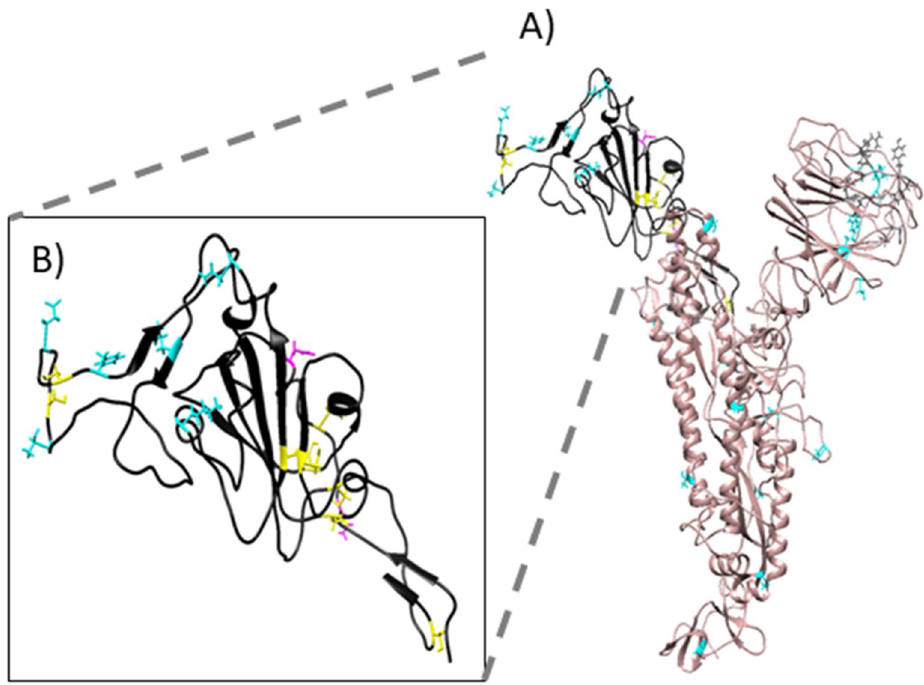
Figure 4. Structure of the spike protein of SARS-CoV-2 and the variants of concern. ( A ) Structure of the spike protein of SARS-CoV-2 in rosy-brown color. ( B ) Zoom of the RBD structure of SARS2-S colored in black. Cys of the RBD are shadowed in yellow and the two glycosylated Asn are magenta. All sites of point mutations in the variants (from Alpha to Lambda) are shadowed in cyan and deletions in grey. Molecular graphics and